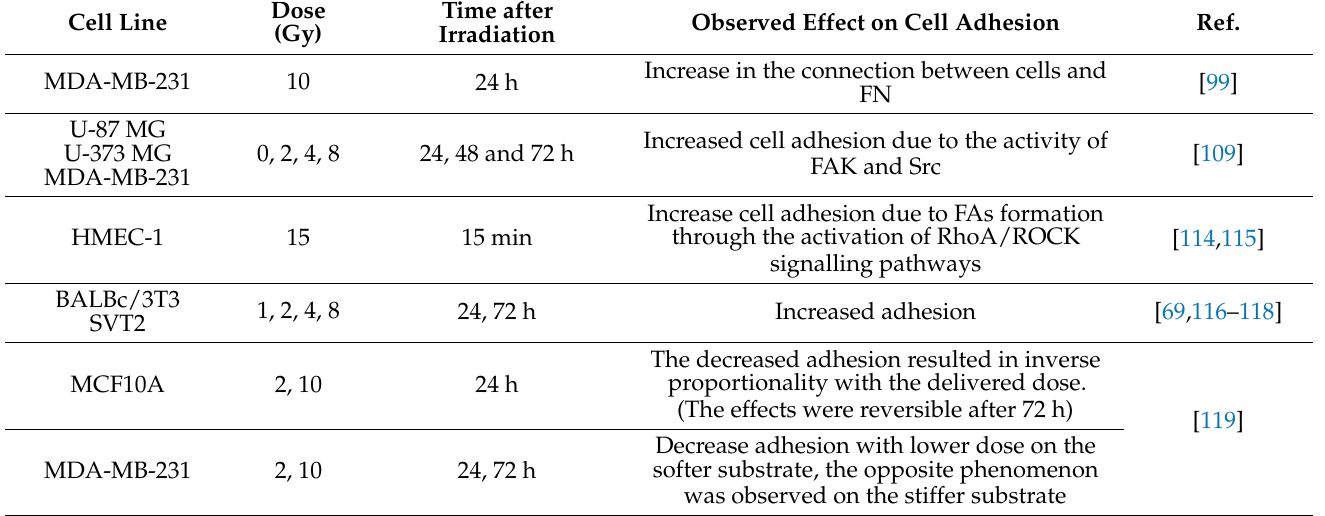
Table 2. Effects of radiation on cell